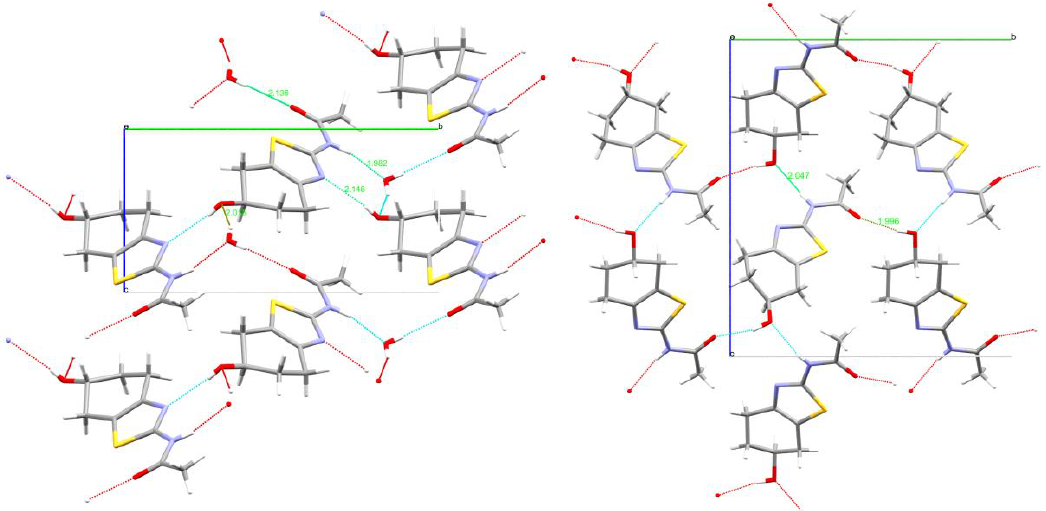
Figure 6. The dashed lines show the intermolecular contacts of ( R )- 4 (left) and of ( S )- 4 (right), viewed along the a axis.